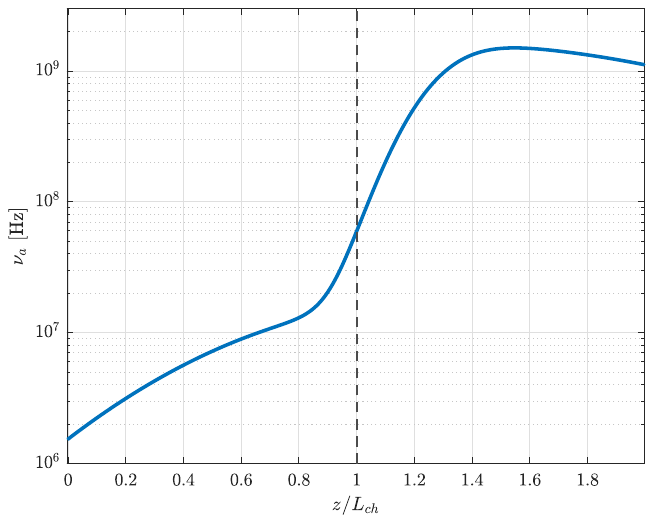
Figure 6. Profile of the anomalous collisionality ν a used in the simulations. Black dashed line indicates the channel exit ( z = L ch )